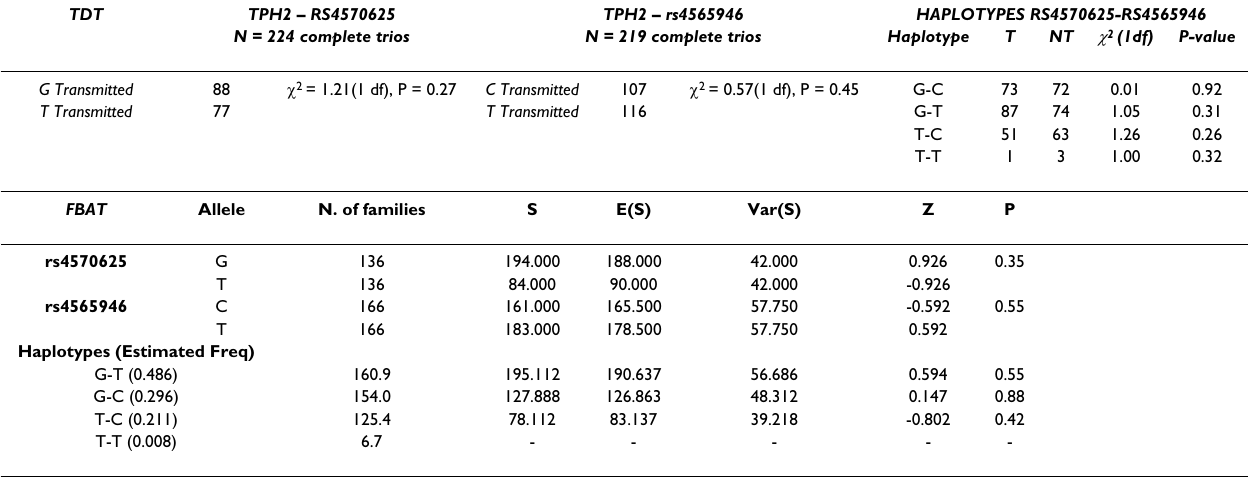
Table 2: TDT and FBAT analyses of SNPs rs4570625 and rs4565946, and relative haplotypes at the TPH2 locus.*